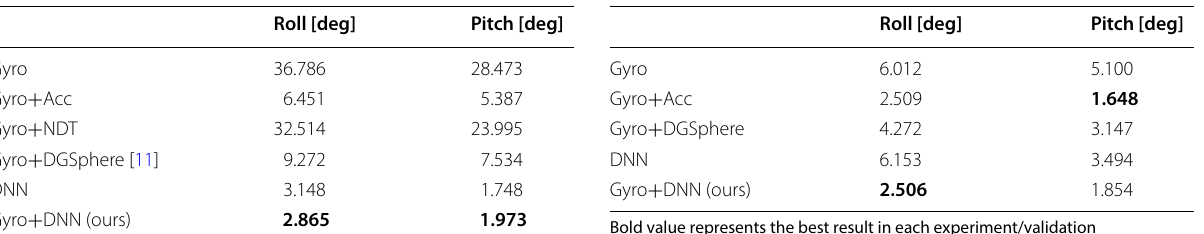
Table 7 MAE of dynamic estimation in mocap area